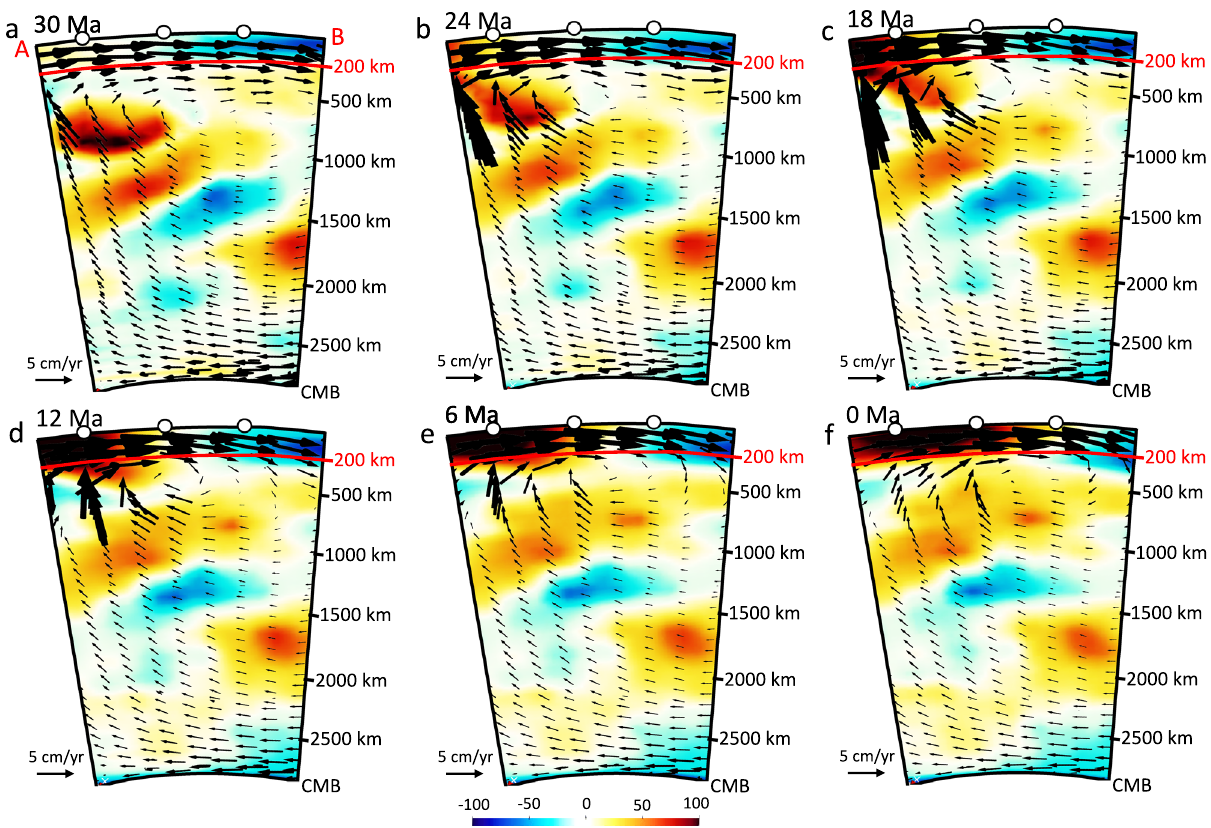
Fig. 3 Evolution of mantle thermal structures beneath the Basin and Range Province since the late Eocene. a – f Radial cross-sections of the reconstructed mantle temperature variations from surface to core – mantle boundary (CMB) along the line A – B at latitude 37 o N in Fig. 4. Superimposed on these cross- sections are the corresponding mantle fl ow velocity vectors. The vectors are extracted from global fl ow fi eld in the mantle ’ s no-net rotation (NNR) frame of reference along a cross section fi xed relative to North America. Panels show landward intrusion of hot anomalies within the Basin and Range Province. The map images were created by authors using: www.soest.hawaii.edu/gmt/ and